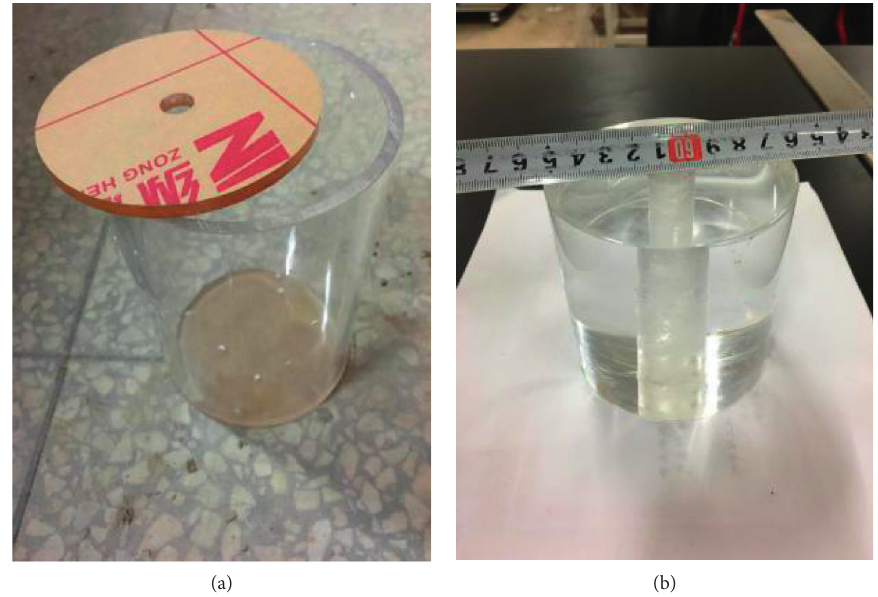
Figure 3: Plexiglass cylinder (a) and plexiglass hollow transfer column